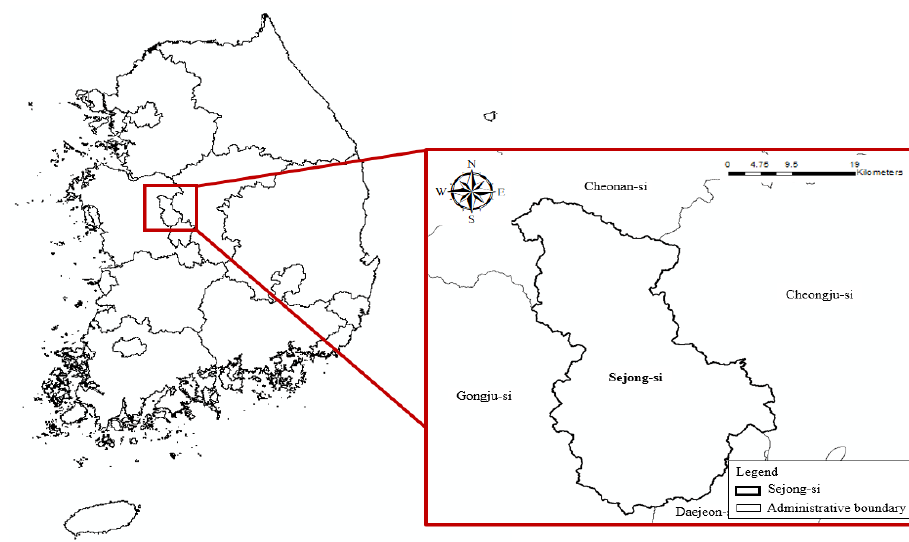
Figure 1. Location of Sejong City,